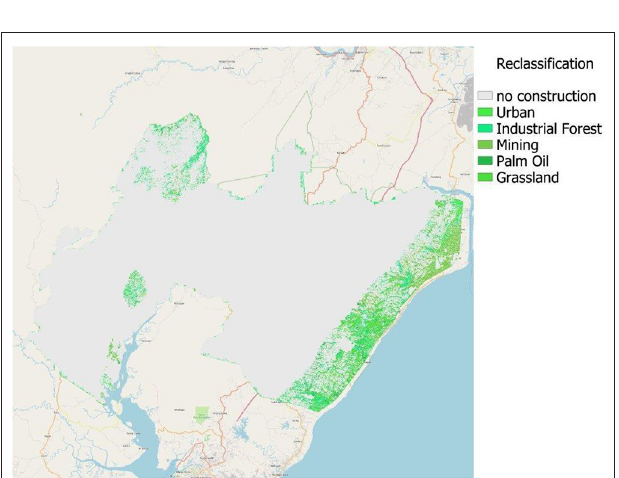
FIGURE 11 | Solar energy potential.